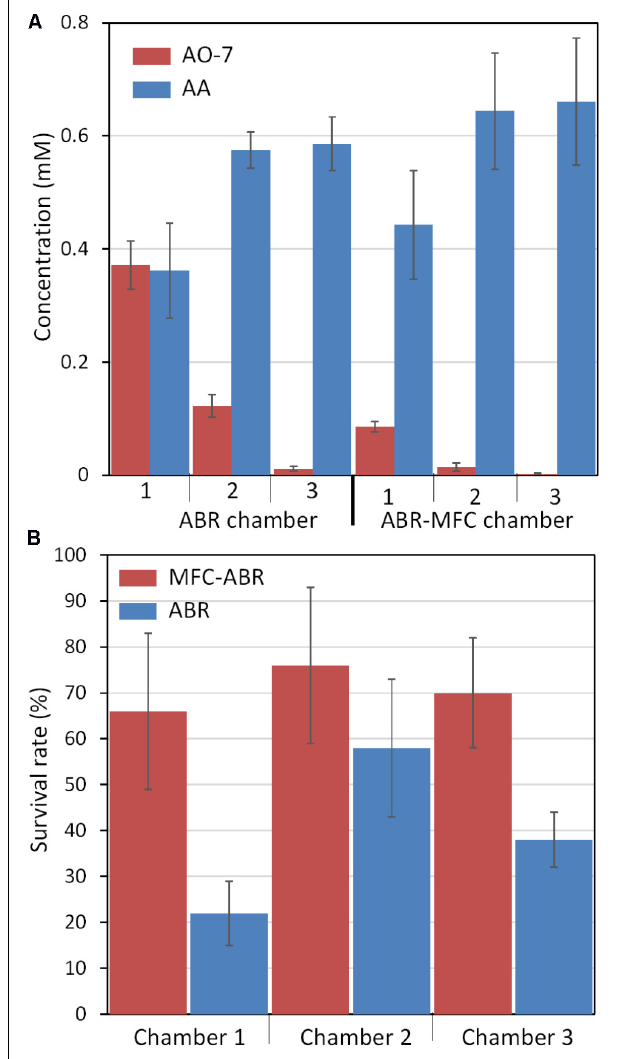
FIGURE 3 | AO-7 reduction products (A) and toxicities (B) in ABRs and